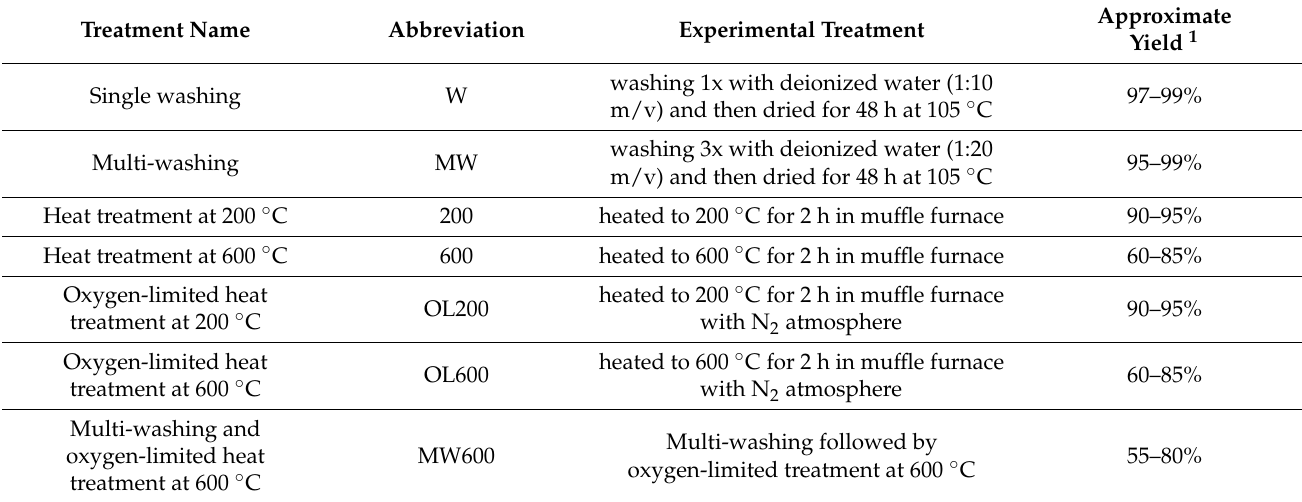
Table 2. Summary of experimental treatments of DWTRs and corresponding